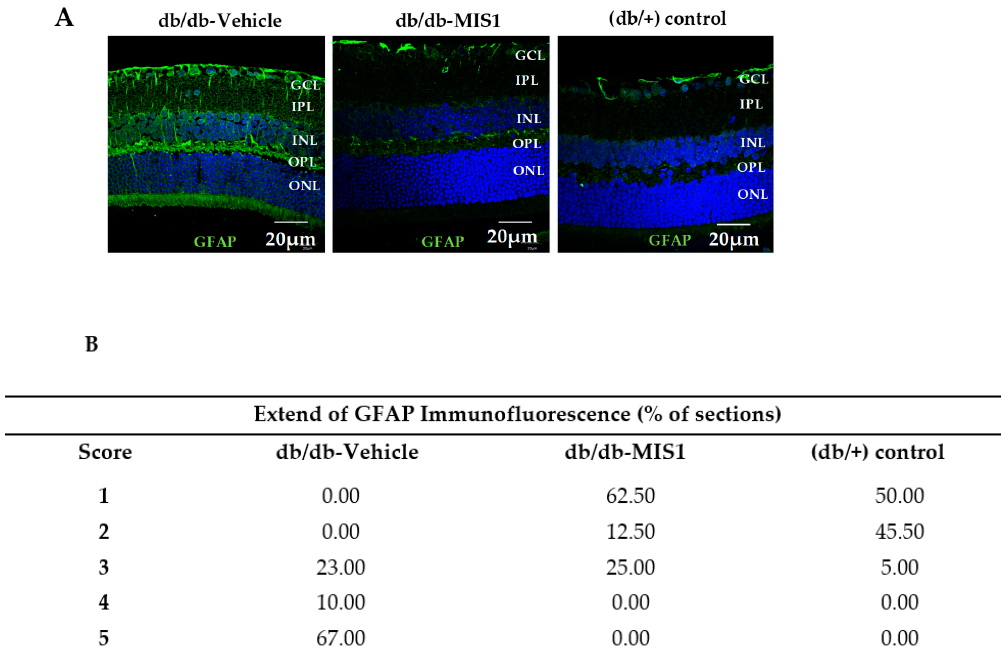
Figure 1. E ff ect of topical (eye drops) SOCS1 peptidomimetic (MIS1) administration on glial activation. ( A ) Comparison of GFAP immunoreactivity (green) in the retina among representative samples from a diabetic mouse treated with vehicle, a diabetic mouse treated with eye drops containing MIS1 and a non-diabetic mouse. Nuclei were labeled with Hoechst (blue). ONL: outer nuclear layer; INL: inner nuclear layer; GCL: ganglion cell layer. Scale bars, 20 µ m. ( B ) Quantification of glial activation based on the extent of GFAP staining. N: 7 mice per